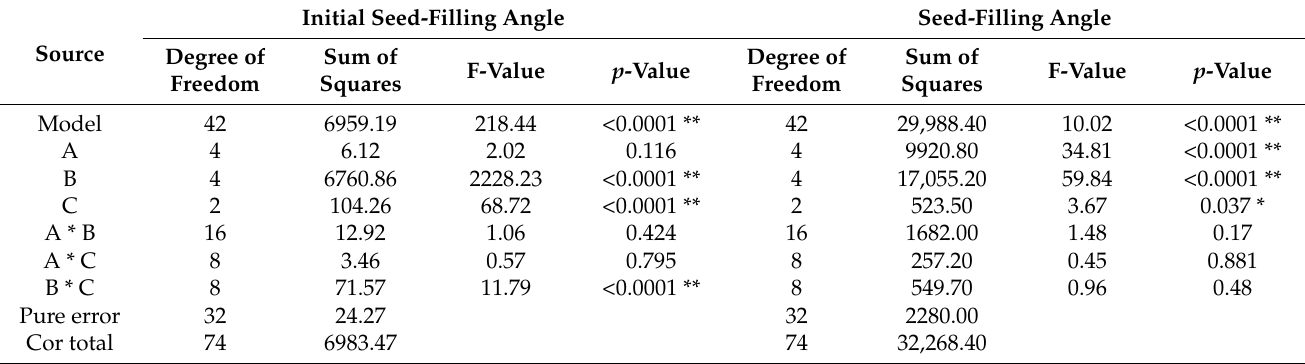
Table 7. Variance analysis of factors affecting initial seed-filling angle and seed-filling